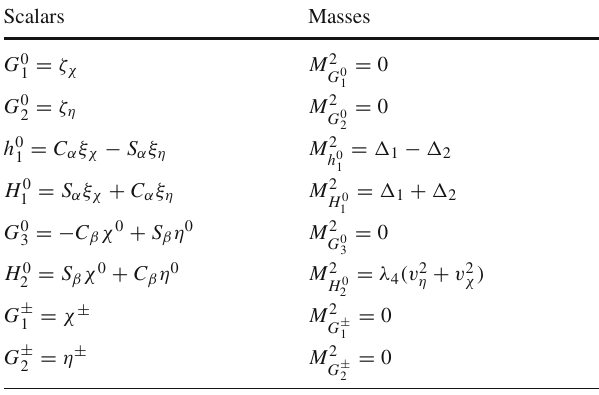
Table 4 Physical scalar mass spectrum